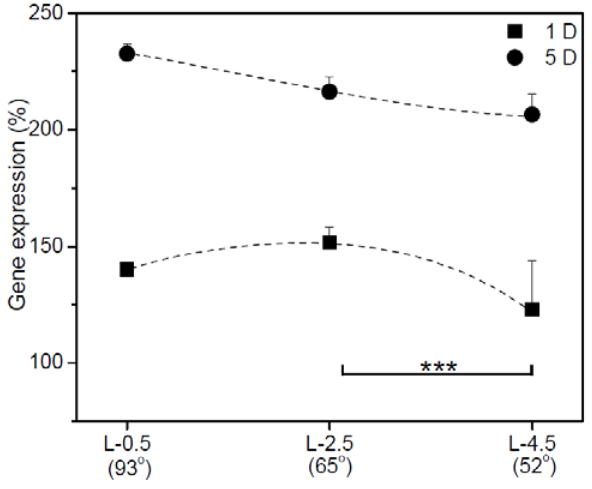
Figure 6. Relative expression of integrin beta 1 in hADSCs after adhesion on each gradient surface (L-0.5, L-2.5, and L-4.5) on days 1 and 5. Levels of messenger RNA (mRNA) were measured with reverse transcription-polymerase chain reaction (RT-PCR) and normalized with β-actin mRNA ( *** p < 0.05).